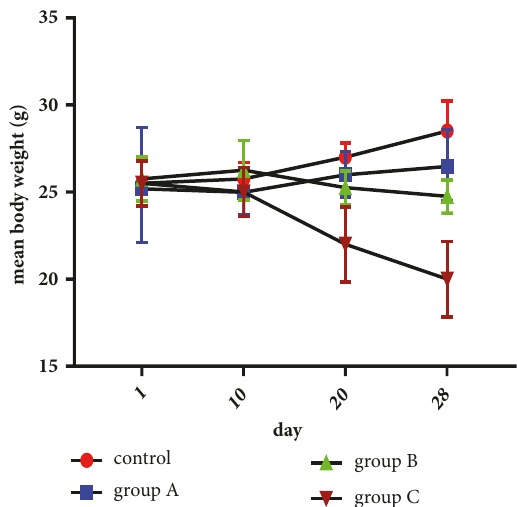
Figure 1: Changes of mice weight during the treatment period with doses 1 g/kg/day (group A), 1.5 g/kg/day (group B), and 2 g/kg/day (group C); results represent the means ± SD (standard